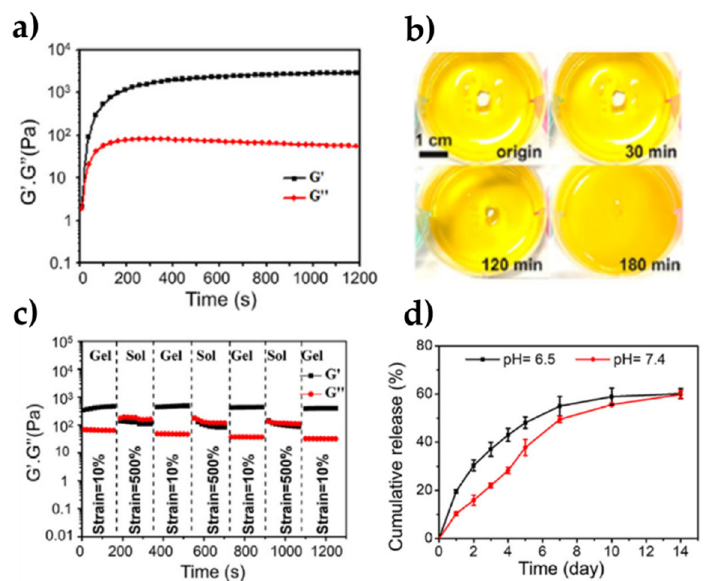
Figure 5. ( a ) G’ and G’’ of the hydrogel as a function of time, ( b ) optical observation of the self-healing process; ( c ) G’ and G’’ of the hydrogel as a function of time during several sol-gel transition cycles; and ( d ) release profiles of insulin from the hydrogel at pH 7.4 and 6.5. Adapted with permission from [38].